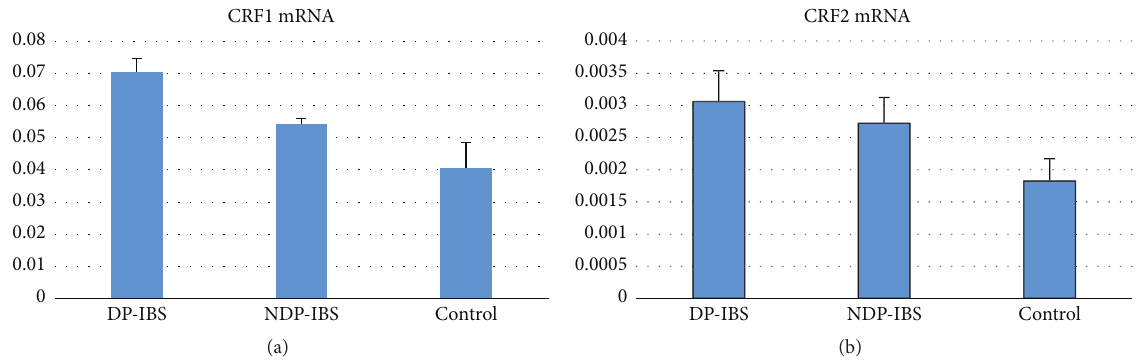
Figure 2: (a) CRF1 mRNA in DP-IBS, NDP-IBS, and control group ( 0.070 ± 0.004 , 0.054 ± 0.002 , and 0.041 ± 0.008 , resp., 𝐹 = 12.047 , 𝑃 < 0.01 ). CRF1 mRNA expression levels in DP-IBS and NDP-IBS patients were significantly higher than those in the control group and in DP-IBS patients were significantly higher than in NDP-IBS patients ( 𝑃 < 0.05 ). (b) CRF2 mRNA expressions in DP-IBS, NDP-IBS, and control group ( 0.0031±0.0005 , 0.0027±0.0004 , and 0.0018±0.004 , resp., 𝐹 = 83.726 , 𝑃 < 0.01 ). CRF2 mRNA levels in DP-IBS and NDP-IBS patients were significantly higher than those in the control group ( 𝑃 < 0.05 ).